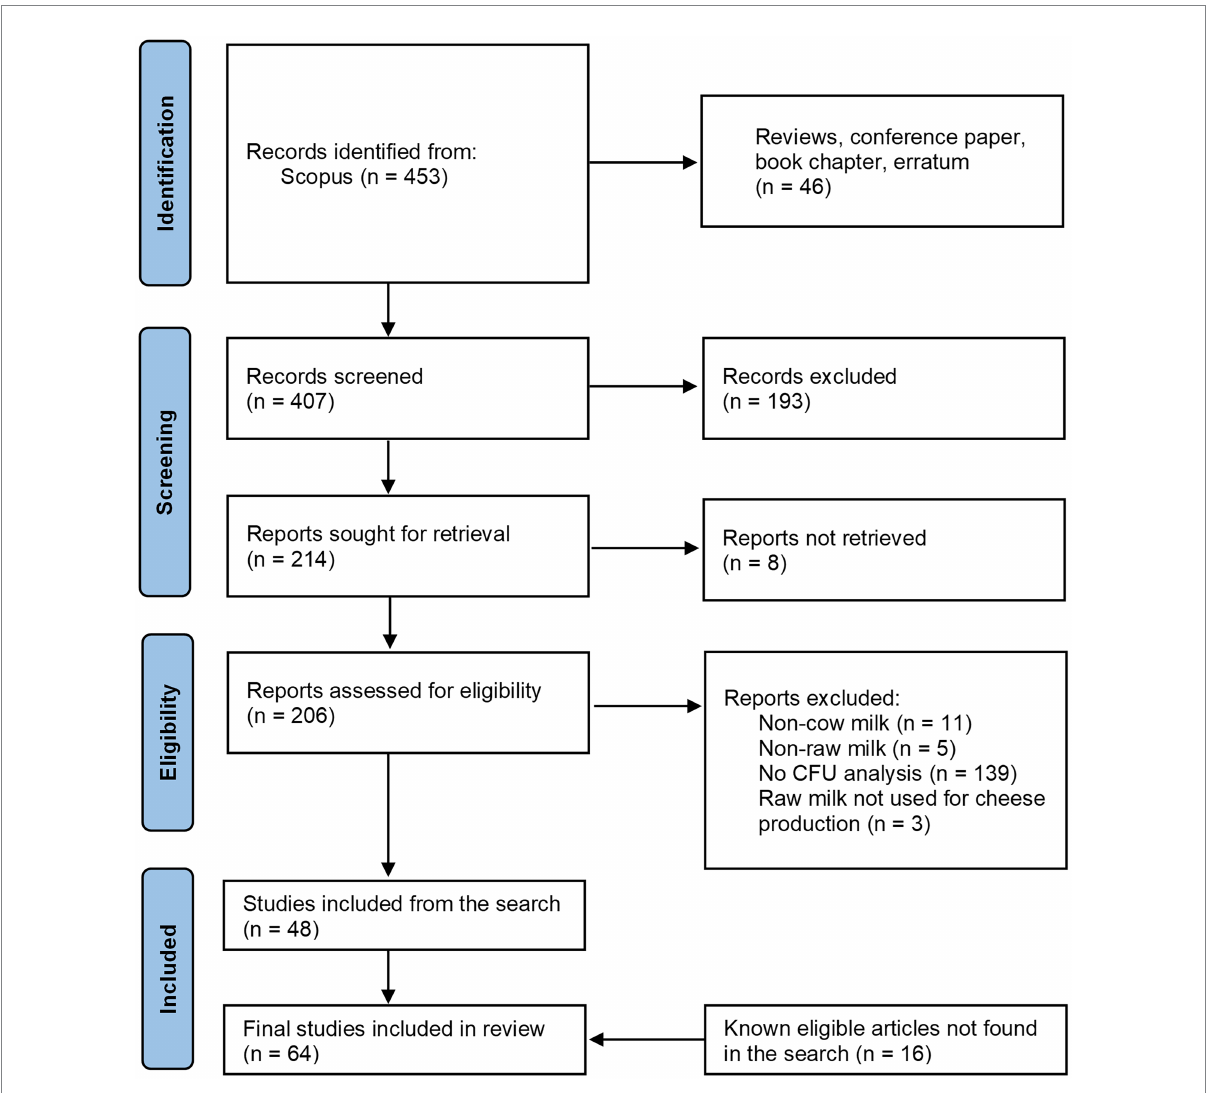
FIGURE 2 Flow diagram of the studies search for the systematic review of plate counts on agar media of Lactic Acid Bacteria in raw milk. CFU, Colony forming